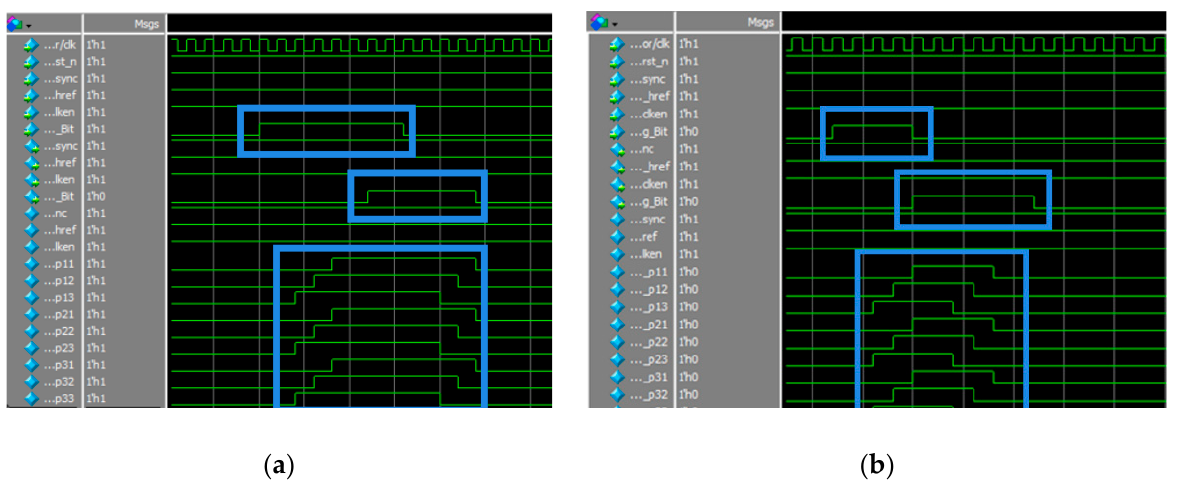
Figure 9. Morphological filtering algorithm simulation module. ( a ) Morphological expansion. ( b ) Morphological